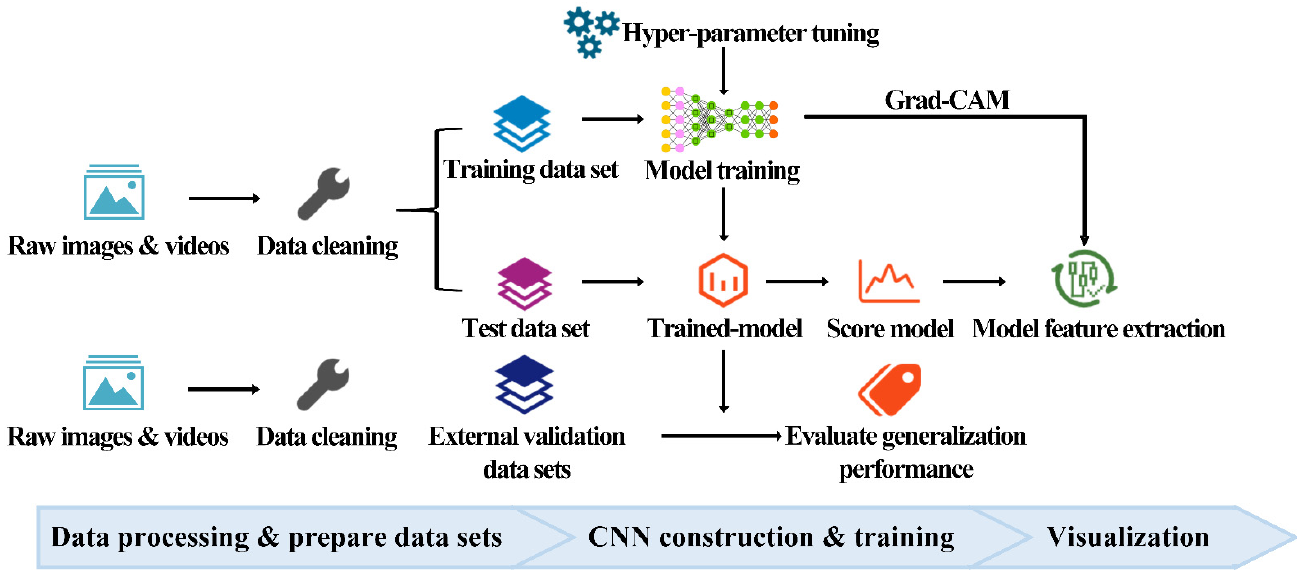
Figure 1. The entire flowchart of this study.